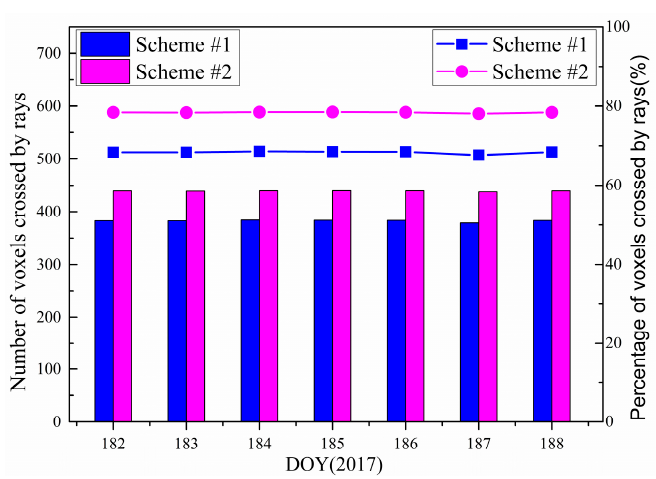
Figure 3. Average number (histogram) and percentage (line) of voxels crossed by signal rays for Scheme #1 and Scheme #2 of DOY 182 to 188, 2017.